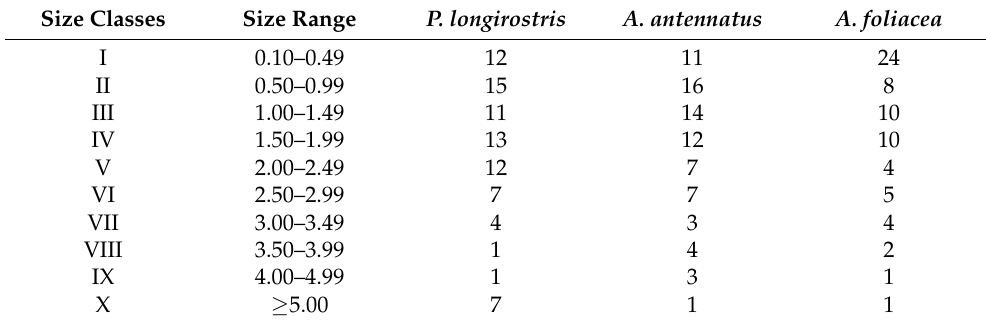
Table 3. Size classes (mm) and number of the MPs isolated from the species analyzed this study.